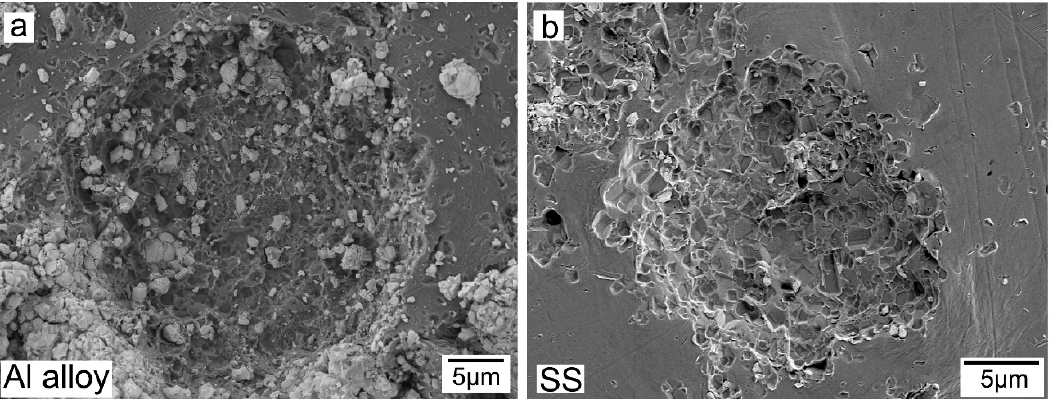
Figure 8. SEM imaging of craters on ( a ) Al alloy and ( b ) SS substrates.